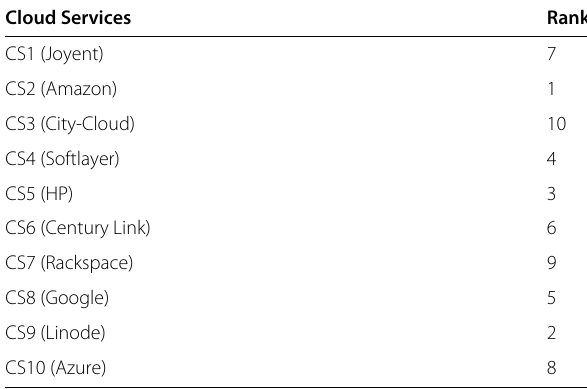
Table 12 Normalized Decision Matrix Cloud Services